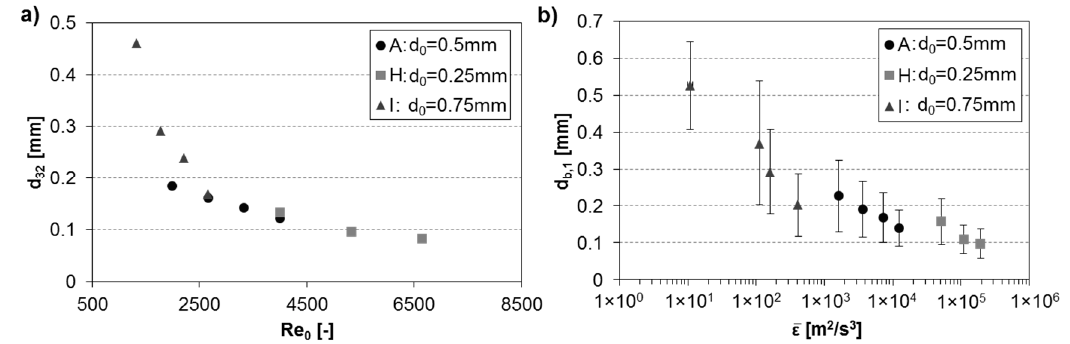
Figure 11. Influence of hydraulic diameter d 0 on bubble breakup behind micronozzles. Constant geometrical nozzle parameter for all displayed inlay elements: d − 1 = 1 mm, α − 1 = 8 ◦ , l 0 = 2.5 mm, α 1 = 47.5 ◦ , d 1 = 1.25 mm. Nozzle inlay A: d 0 = 0.5 mm, nozzle inlay H: d 0 = 0.25 mm, and nozzle inlay I: d 0 = 0.75 mm. Volumetric flow rates are V tot = 60, 80, 100, and 120 mL/min. ( a ) Sauter diameter plotted over Reynolds number in smallest cross section for varied d 0 ; ( b ) mean daughter bubble diameter over mean energy dissipation rate for varied d 0 .